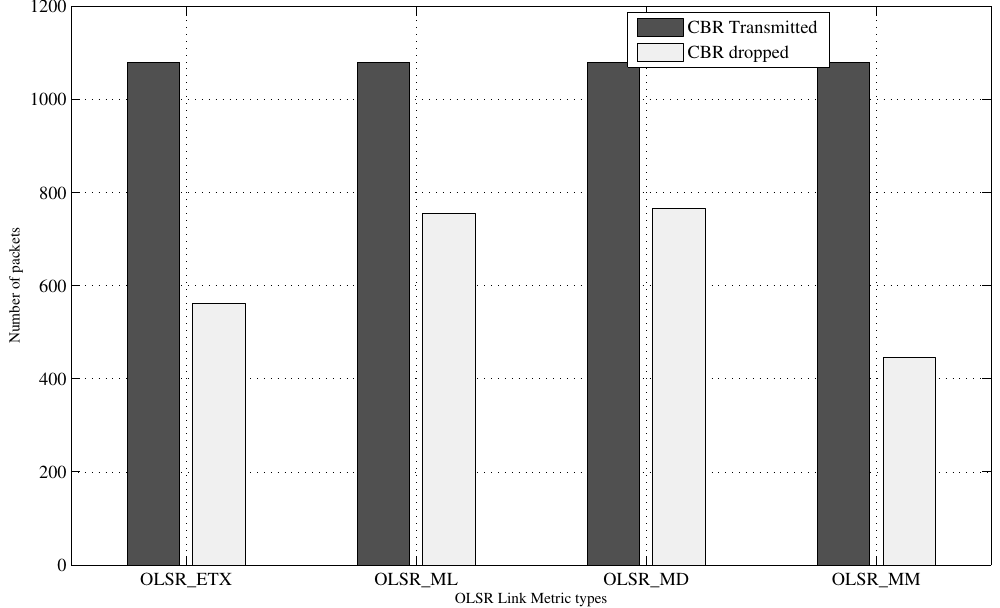
Figure 6. Transmitted and dropped CBR packets for meter reading application.